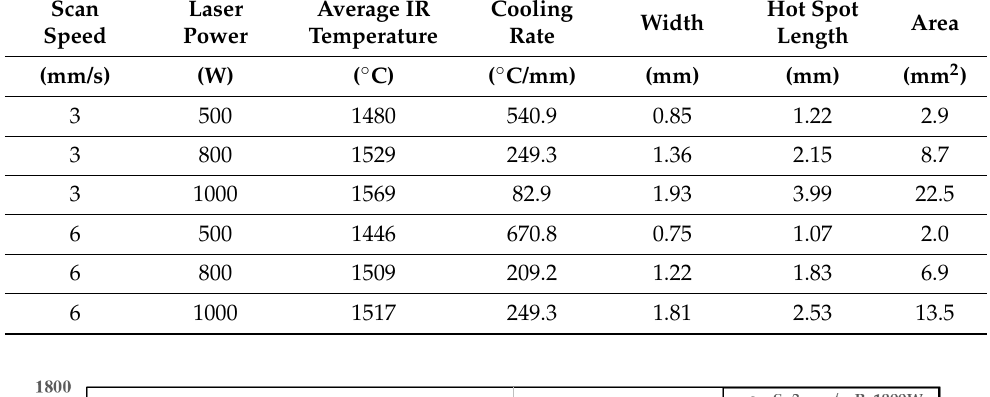
Table 3. Extracted data from infrared images of the cladding hot spot. Figure 9 plots the temperature profiles across the dashed lines of the hot spots in Figure 8. Due to laser energy accumulation on the substrate, the profiles exhibited a greater temperature on the tailing side (left side). When a higher laser power was used, the heat stayed on the substrate for longer before dissipating, resulting in a slower cooling rate. In other words, because heat was limited locally, employing low laser power and fast scanning resulted in a more circular hot spot. According to Figures 8 and 9, the shape of the hot spot was highly related to the condition of the laser cladding and was useful for determining the quality of the cladded substrate. The poor cladding quality can be clearly identified when the hot spot is not well defined and has an irregular shape with a dark region included. Our results agreed with other studies of quality monitoring for laser welding [11,12].